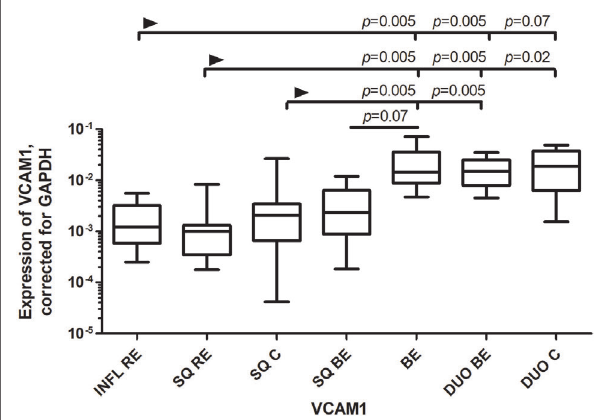
FigUre 2 | Similar expression of VCAM-1 in Barrett’s esophagus (BE) and duodenal tissues. Figure 2 represents expression of VCAM-1 on the y -axis, corrected for GAPDH, 2 −Δ CT ± SEM. The Kruskal–Wallis test was used to compare the groups. The Kruskal–Wallis test was used to compare all the groups ( p < 0.0001), p -values from comparing individual groups were obtained by using Mann–Whitney U test in case of individual groups and Wilcoxon signed rank test for different tissue types from the same patient. Adjustment for multiple comparison was conducted by Benjamini–Yekutieli